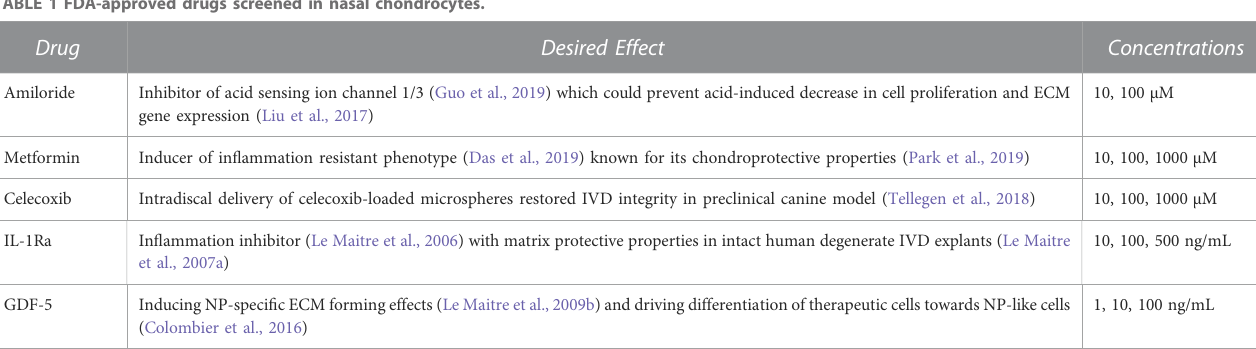
TABLE 1 FDA-approved drugs screened in nasal chondrocytes.